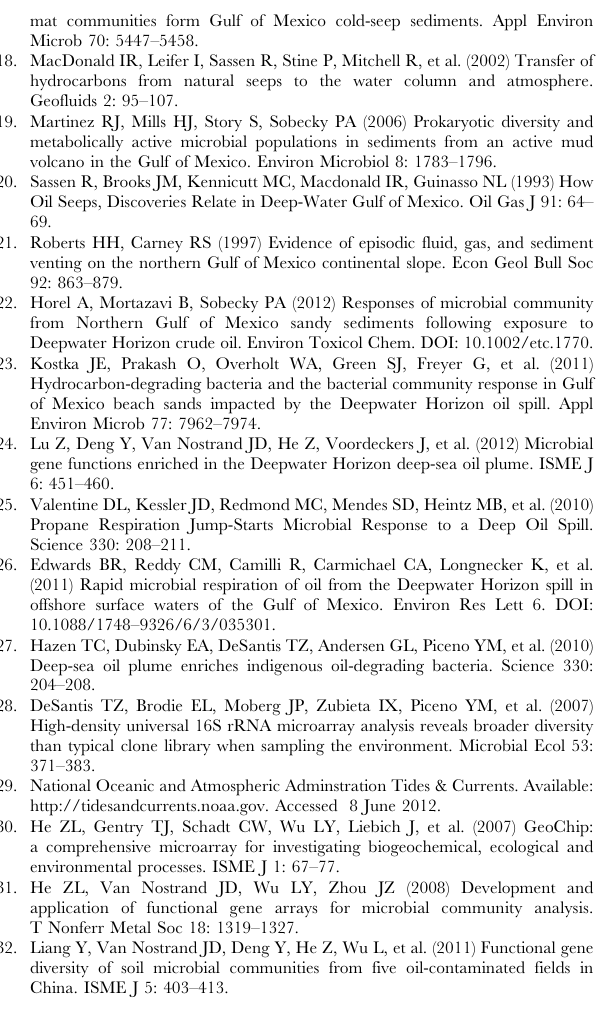
Table S1 Total number of bacterial OTUs detected by PhyloChip in Inlet and Marsh sediments in all phyla. (PDF) Data S1 Total bacterial OTUs detected by PhyloChip for all samples. Positive fraction and normalized fluorescence intensity values are reported. (XLSX) Data S2 Functional gene normalized signal intensities detected by